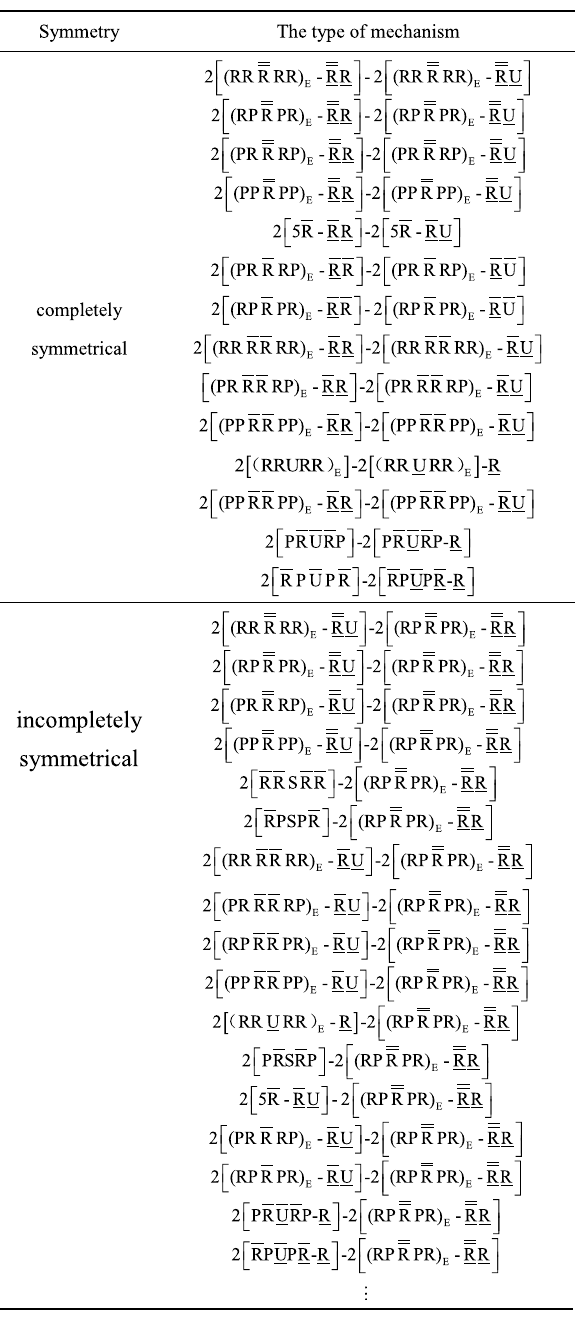
Table 4 The first kind of mechanisms with closed loop unit redundant